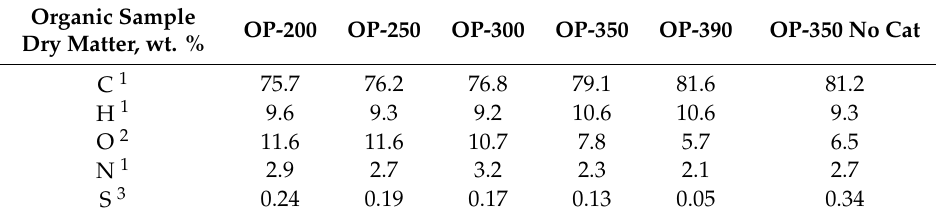
Table 3. Elemental analysis of organic-rich phases (OP) of Py-SS hydrotreatment. Organic Sample Dry Matter, wt.